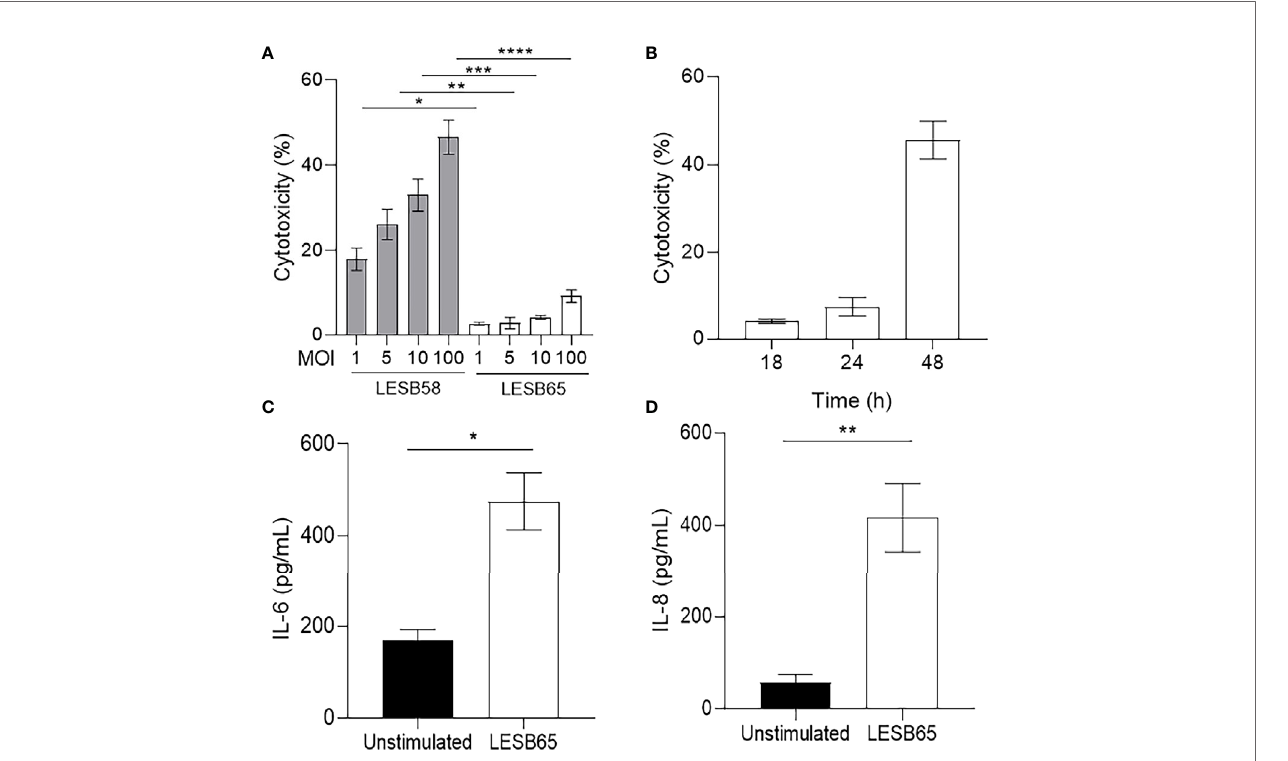
FIGURE 4 | Host response to P. aeruginosa LESB strains in vitro . (A) Human bronchial epithelial cells (HBE) were infected with P. aeruginosa LESB58 or LESB65 at a multiplicity of infection (MOI) of 1, 5, 10, or 100 for 18 h. Amount of LDH in host-cell supernatants was quanti fi ed for determination of cytotoxicity. (B) At MOI = 10, P. aeruginosa LESB65 took 48 h to elicit cytotoxicity similar to that caused in 18 h by LESB58. Furthermore, P. aeruginosa LESB65 (MOI = 10) mediated signi fi cant production of (C) pro-in fl ammatory cytokine (IL-6) and (D) chemokine (IL-8) by HBE cells 18-h post-infection. Data are shown as mean ± SEM. * P < 0.05, ** P < 0.01, *** P < 0.001, **** P < 0.0001 according to Student ’ s